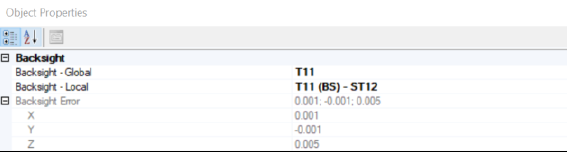
Figure 17 Backsight error obtained from